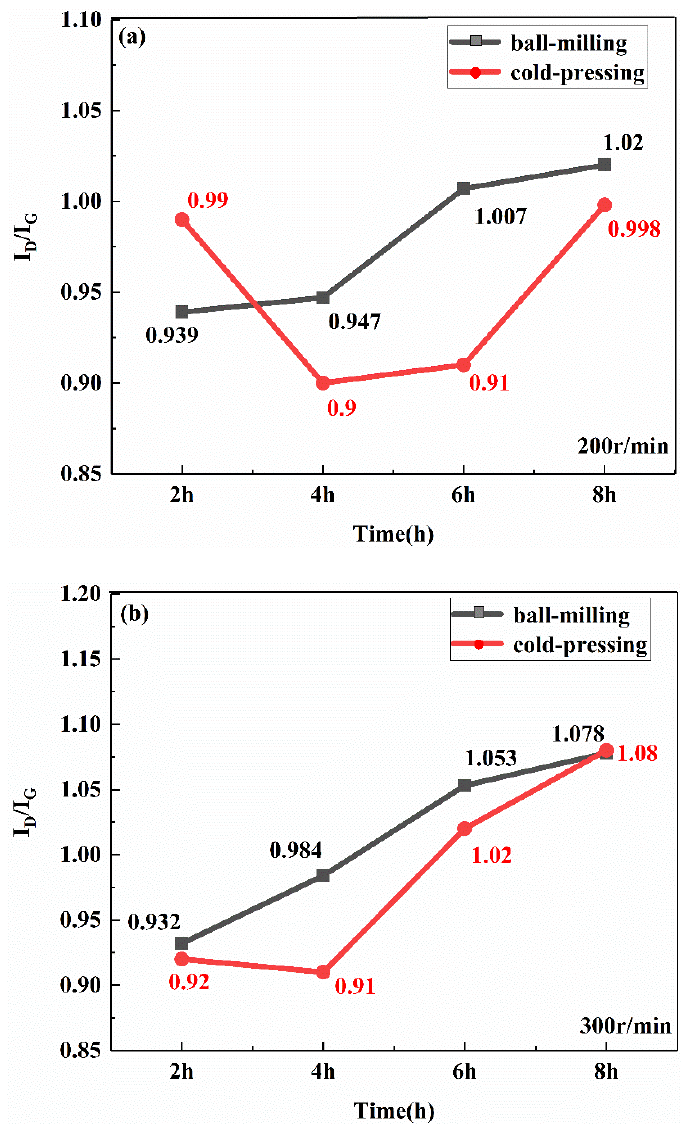
Figure 10. Raman values before and after cold pressing. ( a ) 200 r/min; ( b ) 300 r/min.